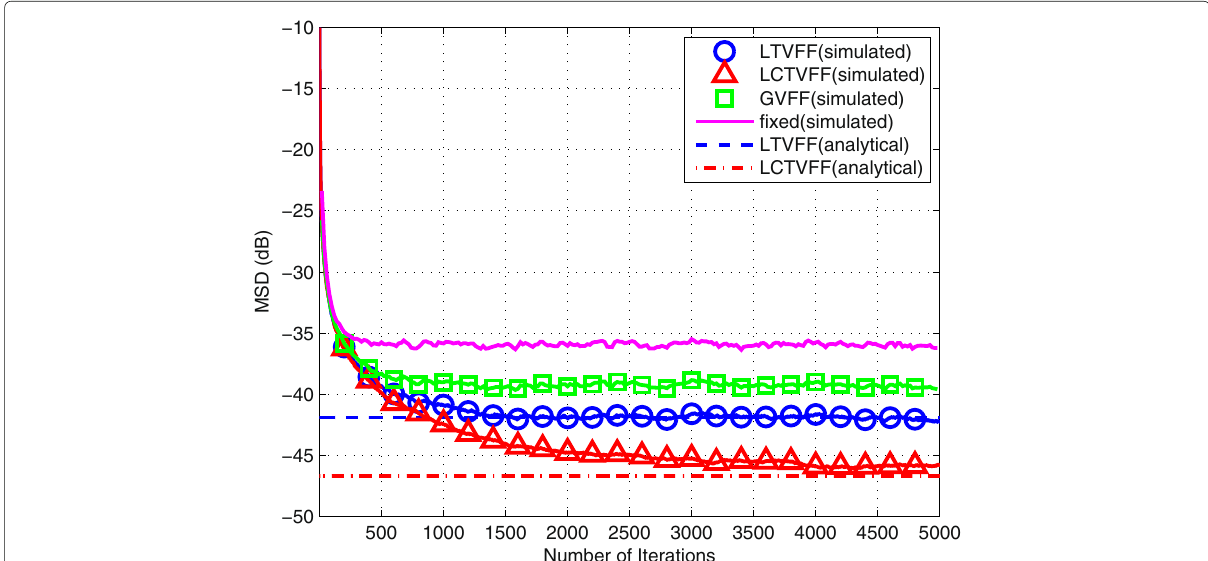
Fig. 10 MSD curve against number of iterations for the proposed and existing